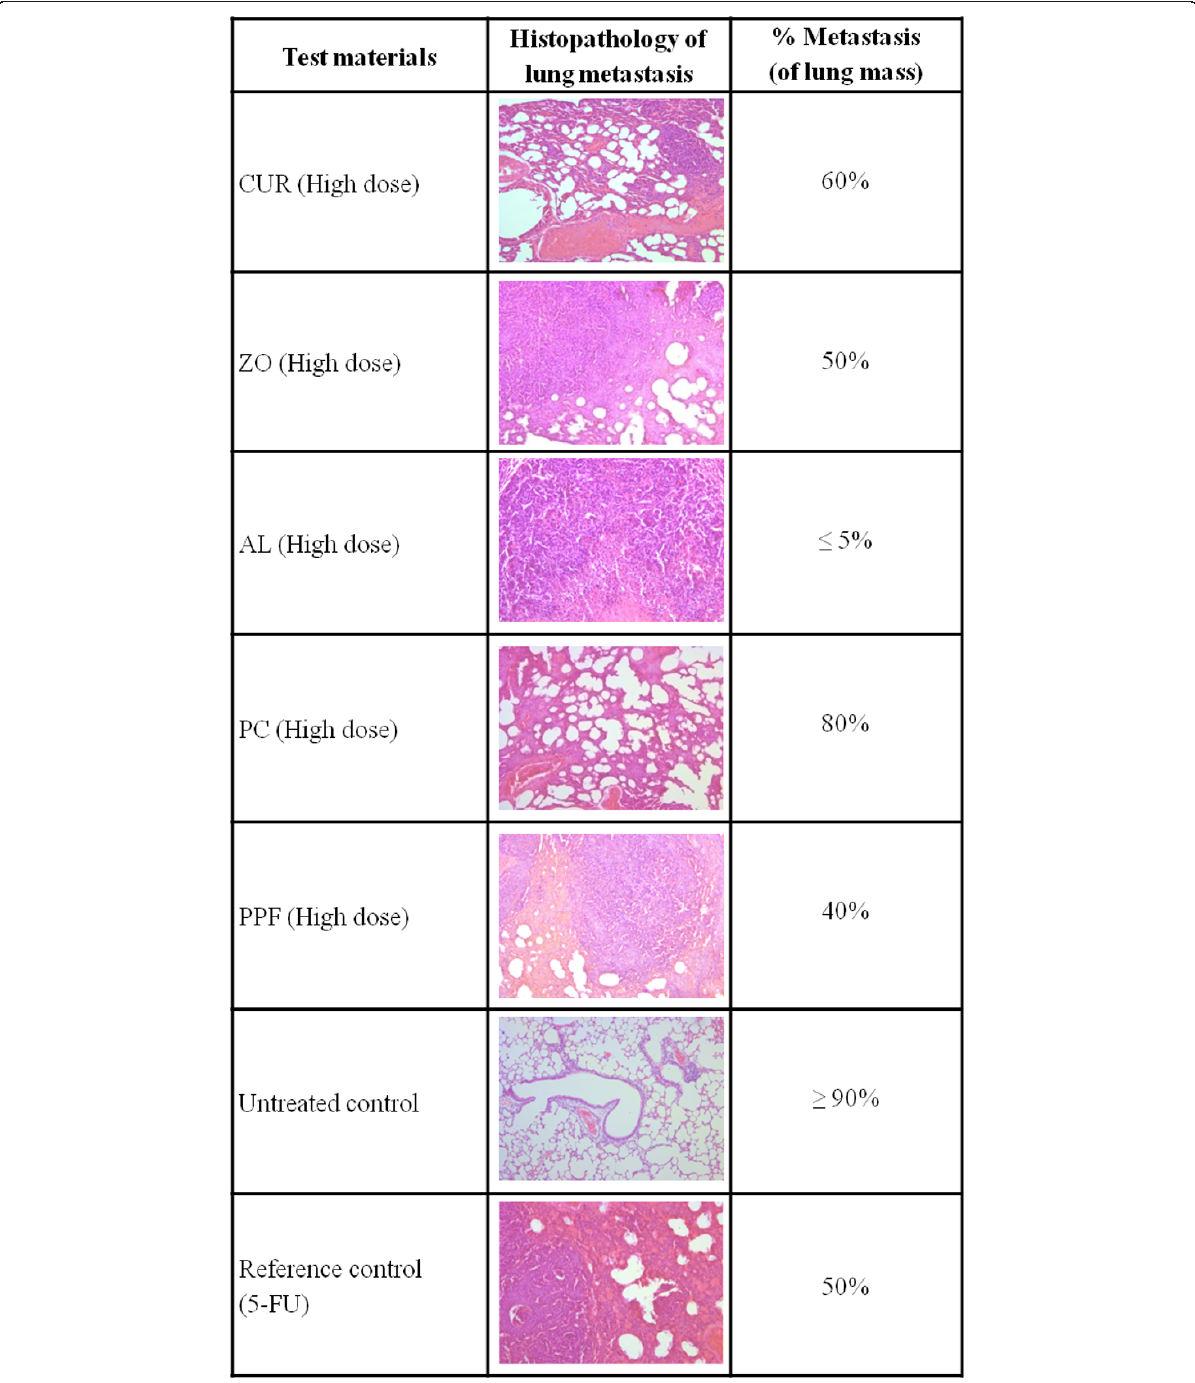
Figure 4 Representative histopathology of lung metastasis of CCA-xenografted nude mice following treatment with the test materials (CUR compound and extracts of ZO, AL, PC, and PPF at various dose levels) in comparison with untreated control and 5-FU (reference control) . % Metastasis of lung mass represents mean (± SEM) from 6 mice for each